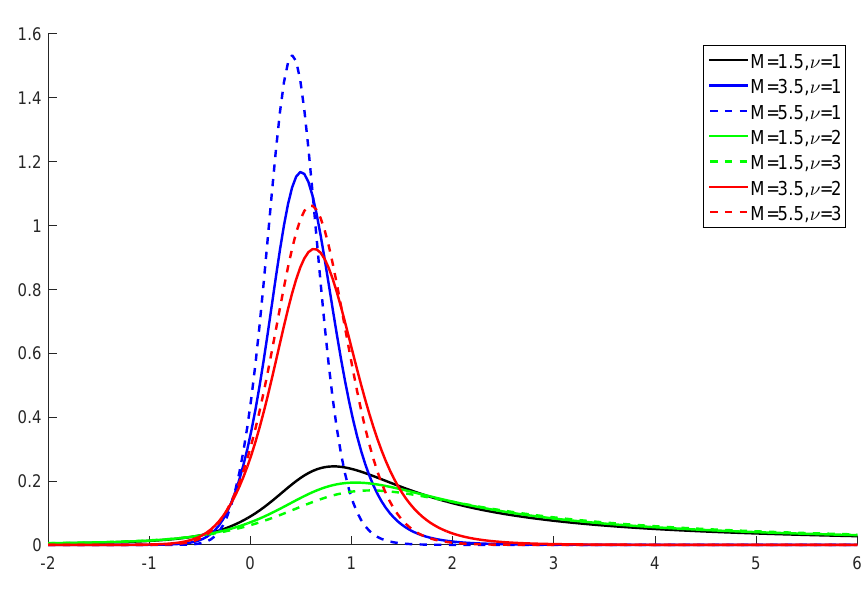
Figure 3: Maximum pdf from l 4,3 -symmetric sample vector distribution, f 4:4 , if the dg is g (4)